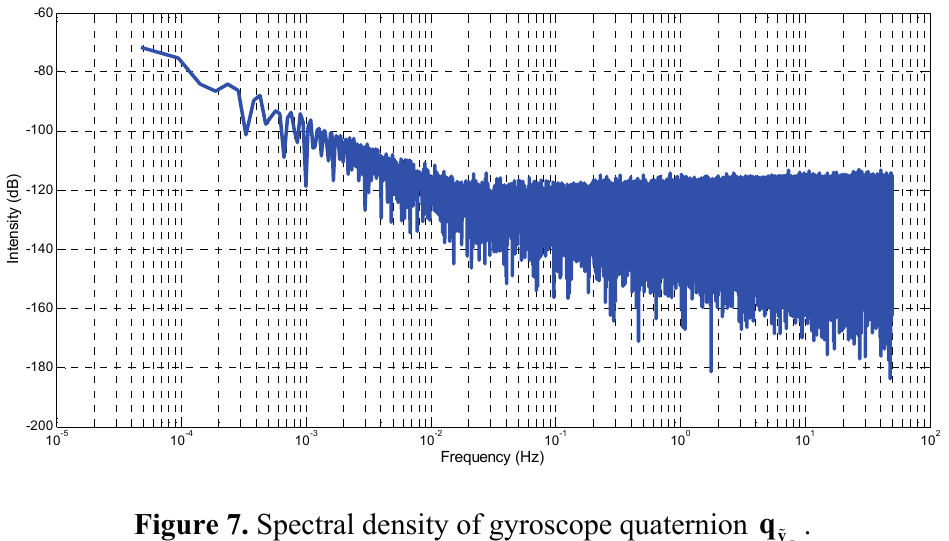
Figure 7. Spectral density of gyroscope